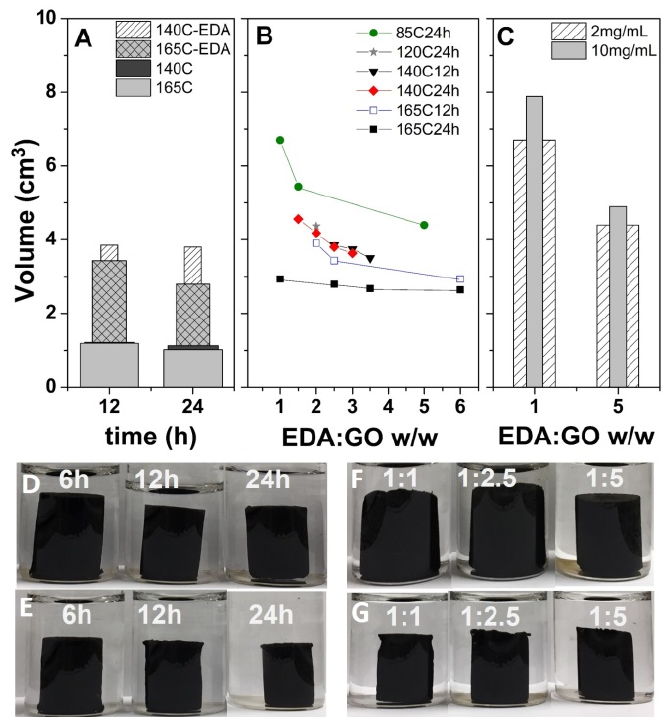
Figure 1. Hydrogel volume evolution in the absence and in the presence of ethylenediamine (EDA) (2.5) ( A ), evolution with EDA content ( B ), and evolution with graphene oxide (GO) concentration at 85 ◦ C for 24 h ( C ). Digital images of 1:2.5 GO/EDA hydrogel evolution with time at 140 and 165 ◦ C ( D , E ). Digital images of hydrogel evolution with EDA at 85 and 165 ◦ C for 24 h ( F , G ).